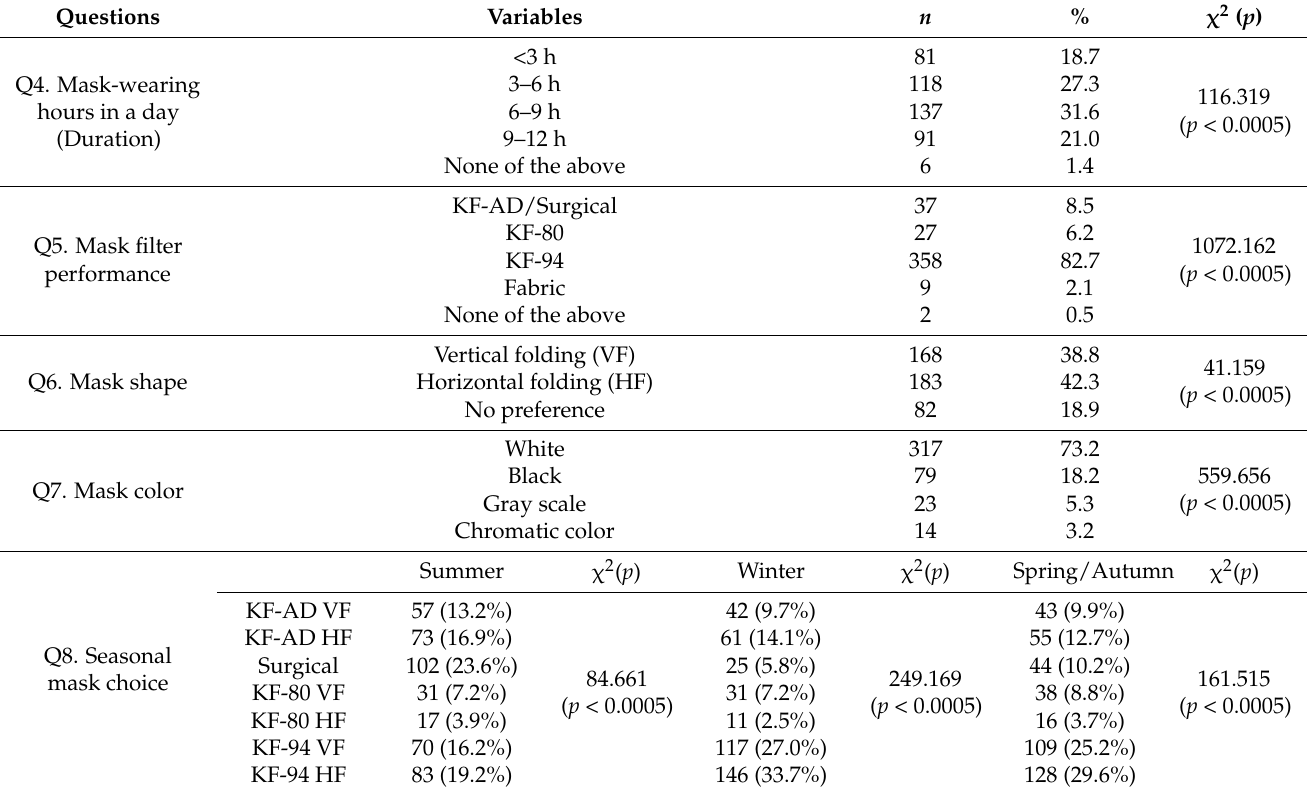
Table 2. Survey results: daily choice of face